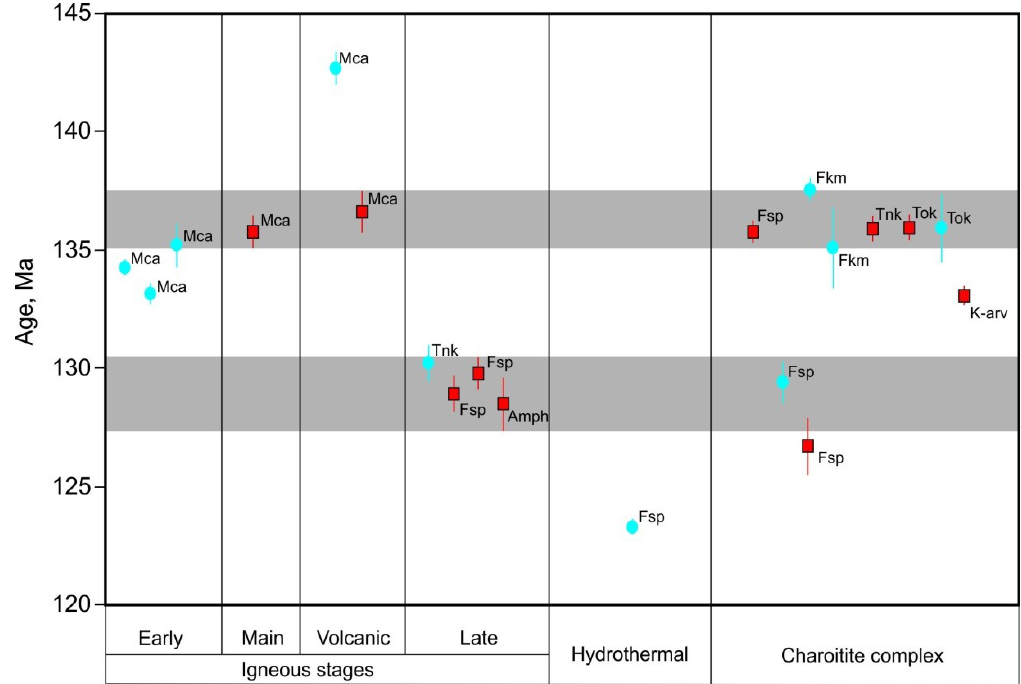
Figure 13. Summary of 40 Ar/ 39 Ar age values for the Malyy Murun massif (see Appendix A). Red squares and blue circles denote the plateau and sub-plateau/isochron age values, respectively. Horizontal grey bands show the reliably-dated intervals of igneous activity within the Malyy Murun